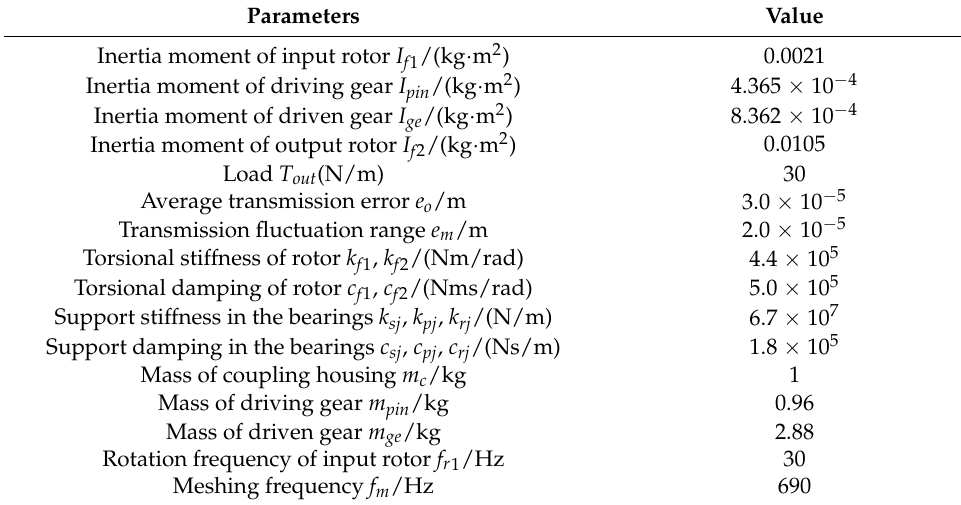
Table 3. Parameters of the bearing-rotor-gear system